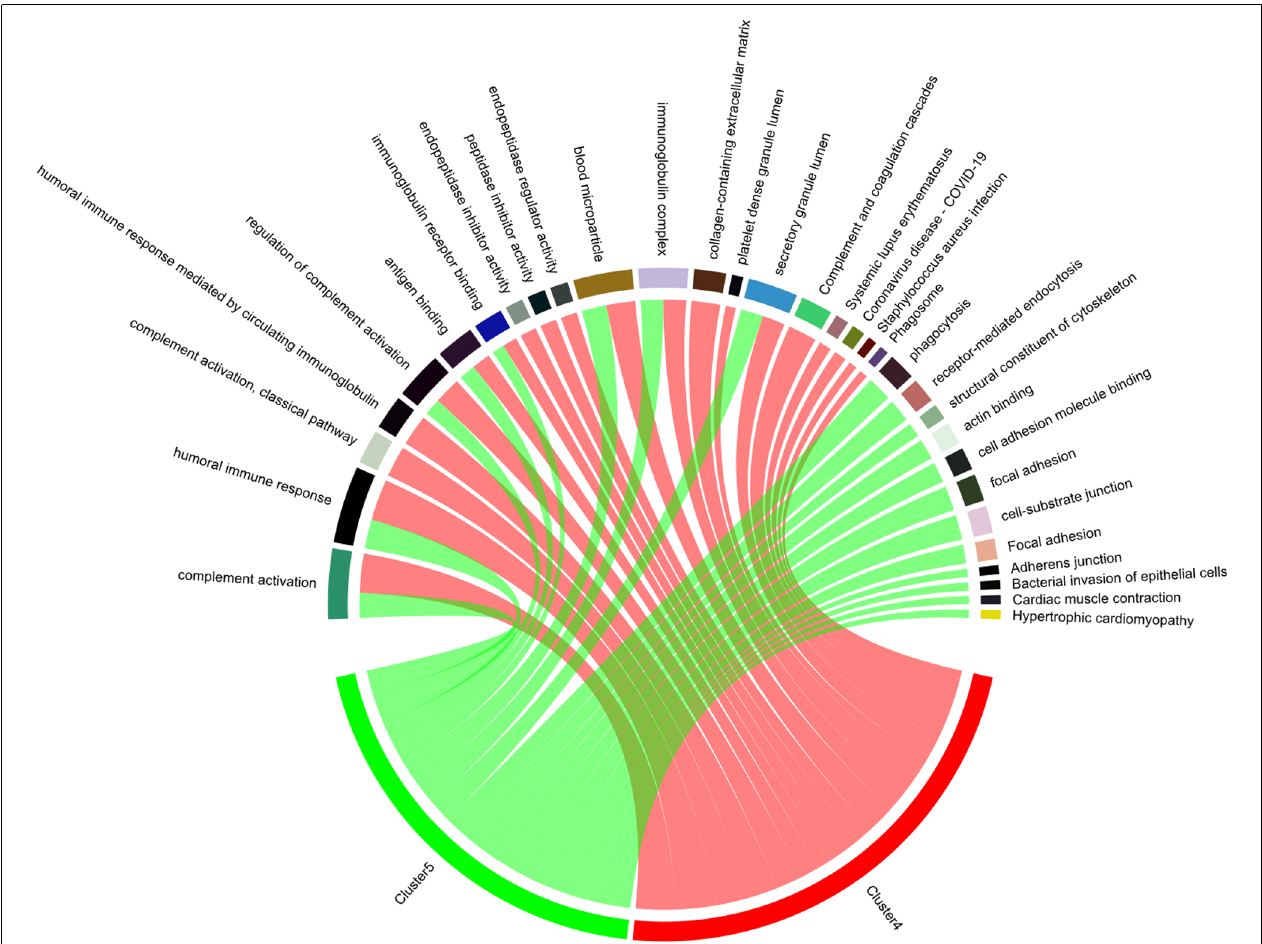
FIGURE 5 | Enriched biological processes of bridge proteins. The participation of bridge proteins in the top five enriched GO terms/KEGG pathways are shown in a chord diagram. The sectors correspond to the top five enriched GO-BP/GO-CC/GO-MF terms and KEGG pathways with the lowest p -value. The spill-over from “Cluster 4” or “Cluster 5” sector to other sectors indicates the number of bridge proteins involved in different GO terms/KEGG pathways. Notably, the intersection between pathways regulated by Cluster 4/Cluster 5 bridge proteins are: “complement activation,” “humoral immune response,” “regulation of complement activation,” “antigen binding,” “immunoglobulin receptor binding,” “blood microparticle,” and “secretory granule